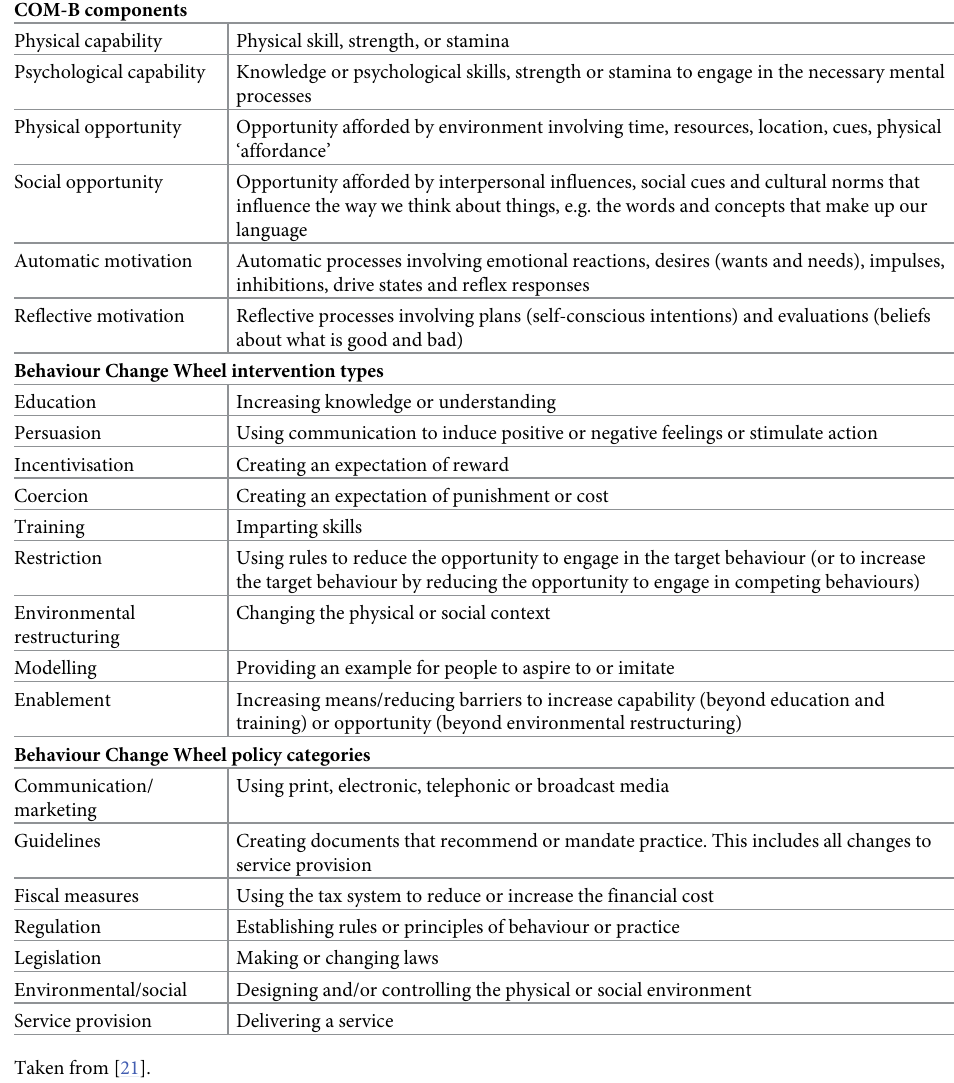
Table 1. COM-B and Behaviour Change Wheel (BCW)